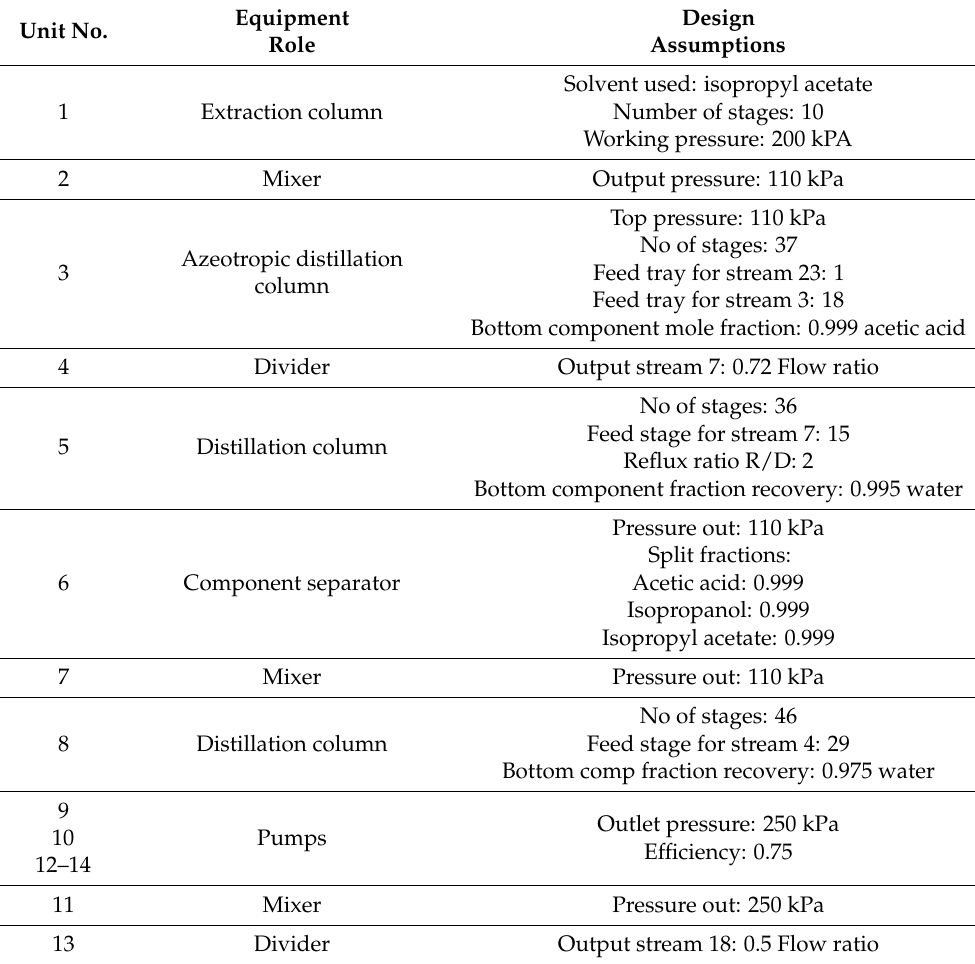
Table 2. Design assumptions of the main units for case 2. Unit